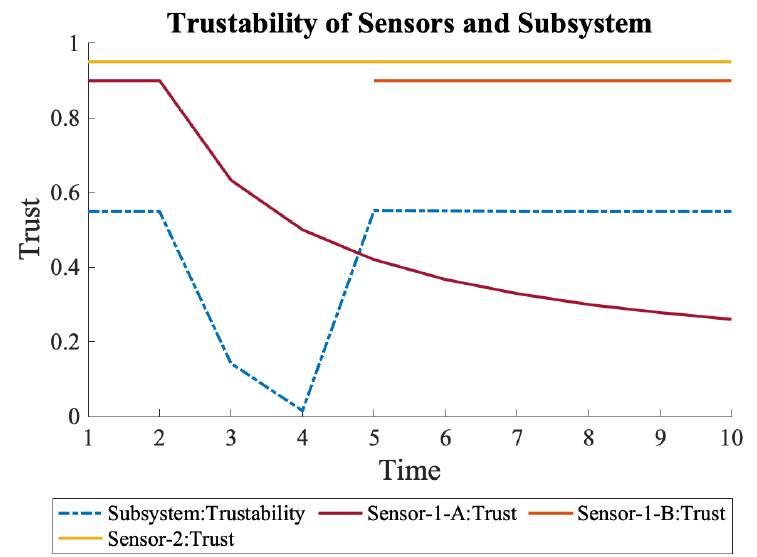
Figure 8. The overall trustability of System-3 and the sensors. S1-B is only activated after distrust of S1-A decreases the system’s trustability below a threshold. Activation takes time.